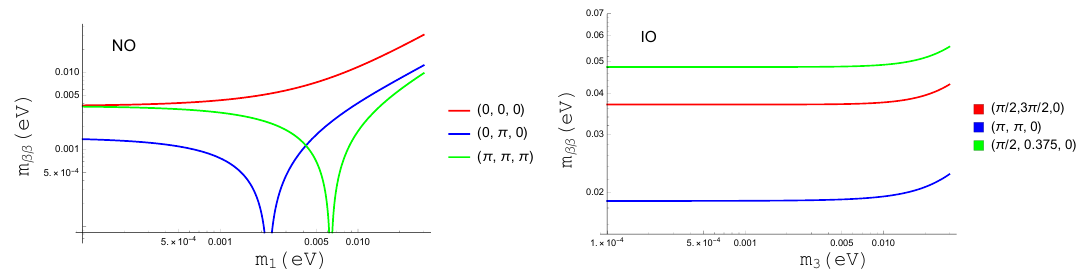
Figure 11 . Expected values of the m ββ parameter relevant for neutrinoless double beta decay experiments for different sets of neutrino CP phases ( δ CP , α 21 , α 31 ) and varying lightest neutrino mass, for NO (Left) and IO (Right). All other parameters are given by the best fit parameters